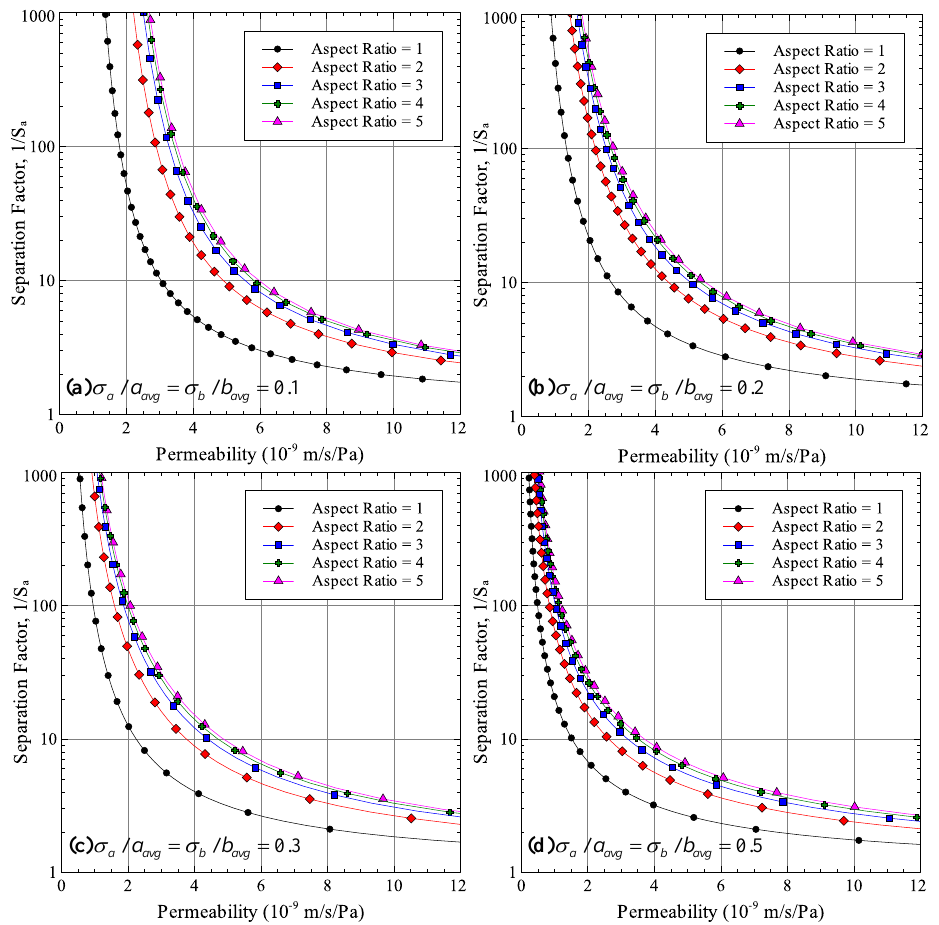
Figure 2. Effect of pore aspect ratio on permeability-selectivity trade-off.